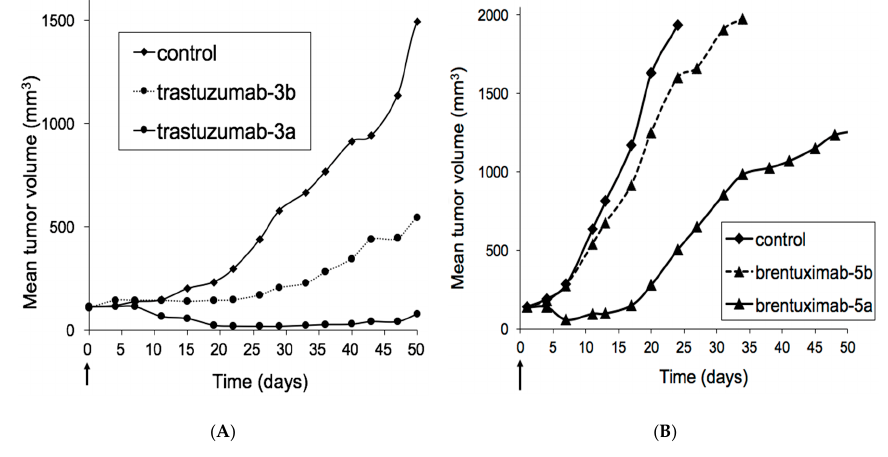
Figure 3. ( A ) In vivo efficacy of HydraSpace™-derived 3a or PEG only variant 3b in HBCx-13B patient-derived xenograft (PDX). A single dose of either ADC (6 mg/kg) was administered on t = 0 and tumor size was monitored over time ( n = 5); ( B ) In vivo efficacy in Karpas-299 xenograft (CDX) of ADCs derived from brentuximab- 1 conjugated with either HydraSpace™ BCN-MMAE construct 5a or PEG-only variant 5b . A single dose of either ADC (1 mg/kg) was administered on t = 0 and tumor size was monitored over time ( n =